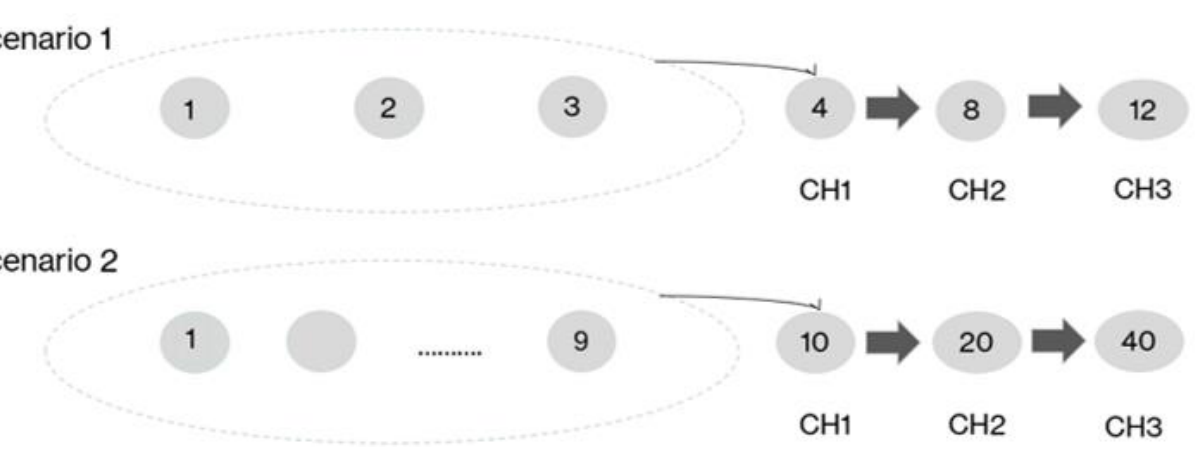
Figure 2. Hierarchical multi-hop communication scenarios.